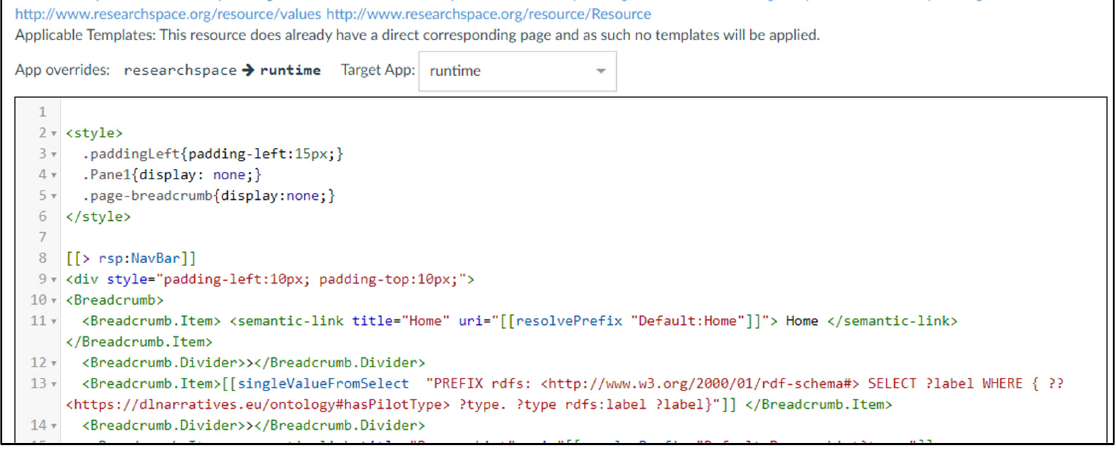
Figure 15. Example of editing an applicable template.